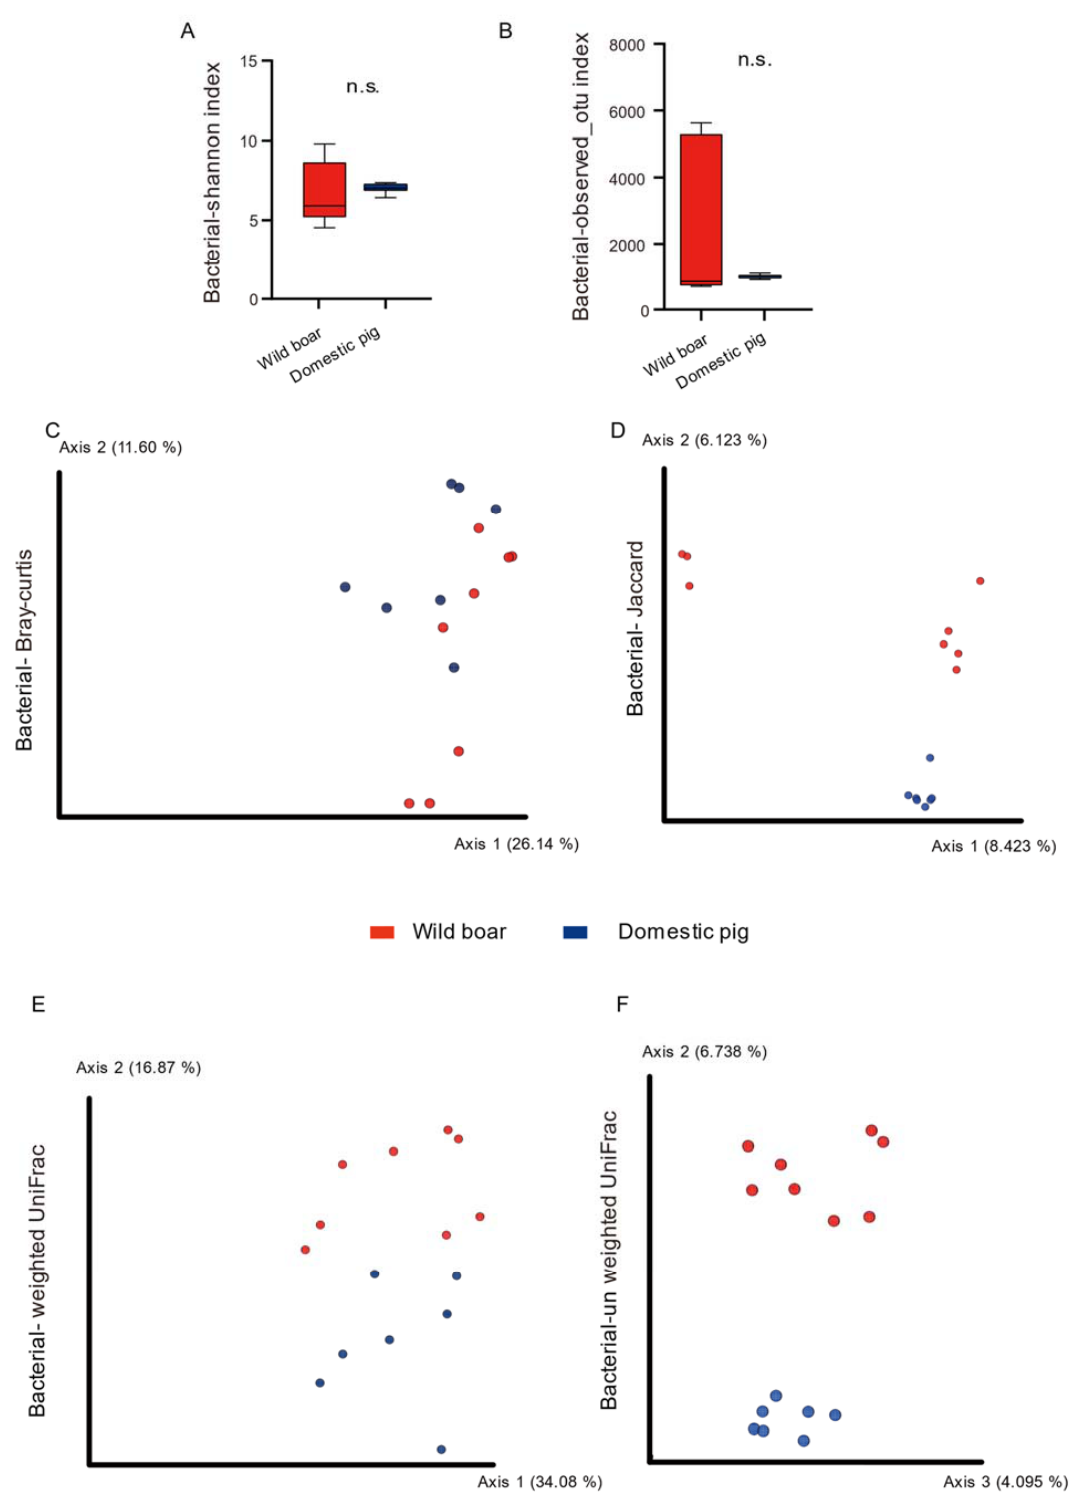
Figure 2. The alpha and beta diversity of pigs’ gut microbiota based on 16S rRNA V3-V4 sequences. Alpha diversity includes Shannon Index ( A ) and Observed OTUs. ( B ): The red and blue bars represent wild boars and domestic pigs, respectively. n.s., no significance, Mann–Whitney U-test. ( C ): PCoA of bacterial Bray–Curtis. ( D ): PCoA of bacterial Jaccard. ( E ): PCoA of bacterial weighted UniFrac. ( F ): PCoA of bacterial unweighted UniFrac. ANOSIM, p < 0.05, the red and blue circles represent the bacterial communities of the wild boars and domestic pigs,